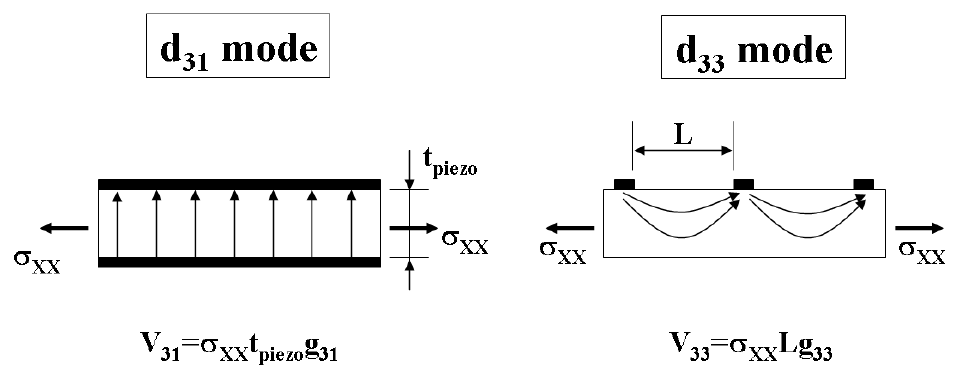
Figure 13. Two modes of piezoelectric conversion from input mechanical